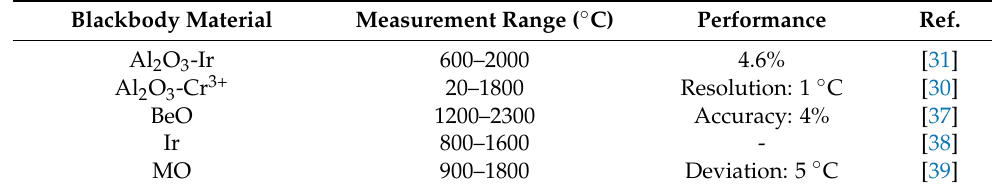
Table 1. Performances comparison of blackbody OFTs.